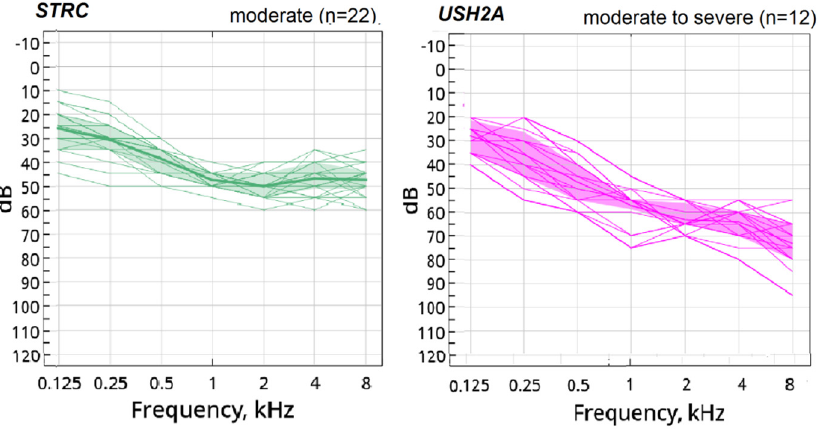
Figure 4. The audiogram profiles for patients with STRC and USH2A pathogenic variants.